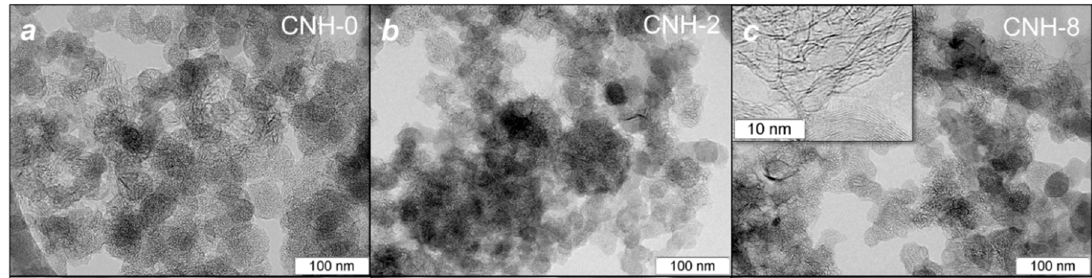
Figure 1. TEM images of samples CNH-0 ( a ), CNH-2 ( b ), and CNH-8 ( c ). Insert in ( c ) shows the image of graphitic-like particles.